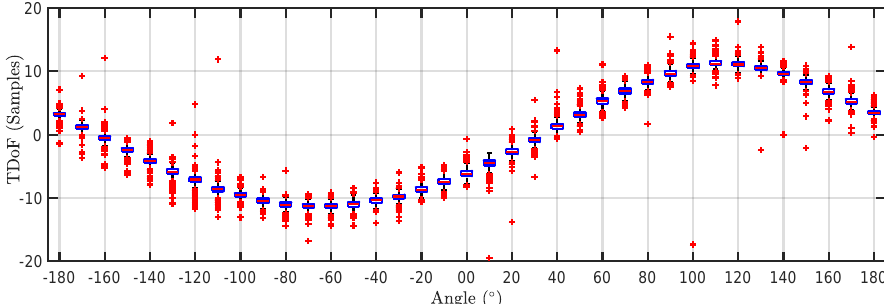
Figure 10. Box plot of the time differences of arrival versus angle of rotation for the pulses generated by source 2 (grey cluster).